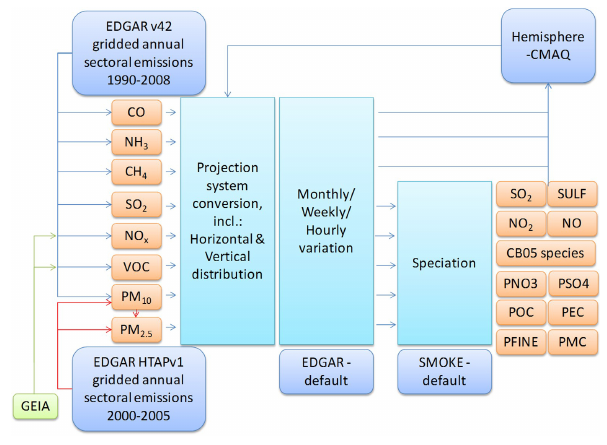
Figure 1. Processes of gridded emissions for Northern Hemispheric WRF-CMAQ